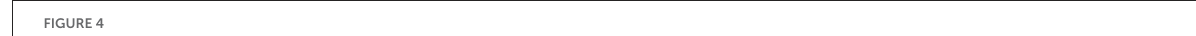
FIGURE4 and Nissl-labeled neurons (blue). (A1–E1) Magnified photographs from the box-indicated regions in (A–E) show the details. (B–E) At 6h, 1, 7, and 14 days after the operation, astrocytes and microglia activated and gathered in the region of infarcts. (F) The area ratio of astrocytes showed an increasing trend after the operation, but there was no statistical significance. (G) The area ratio of microglia significantly increased at all time points after the operation, peaking at 7 days. The astroglial and microglial activation in all model rats presented with a similar pattern ( n = 7). The green dots in (B,C) were lodged in fluorescent microspheres. Scale bars: 200 µ m in (A–E) , 50 µ m in (A1–E3) . * p < 0.05 vs. normal